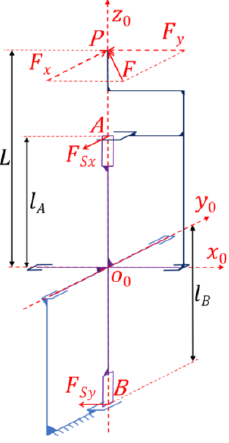
Figure 4. Mechanical analysis diagram of flexible support platform. Force F can be divided into force F x and force F y along the x 0 and y 0 axes in the O 0 x 0 y 0 plane when point P is subjected to force F in the O 0 x 0 y 0 plane. The force F y is applied to the upper connecting block, which is gently deflected around the x 0 axis in the direction of force F y before being forced to compress the pressure sensor B . At this time, force sensor B generates the interaction force F Sy on the upper connecting